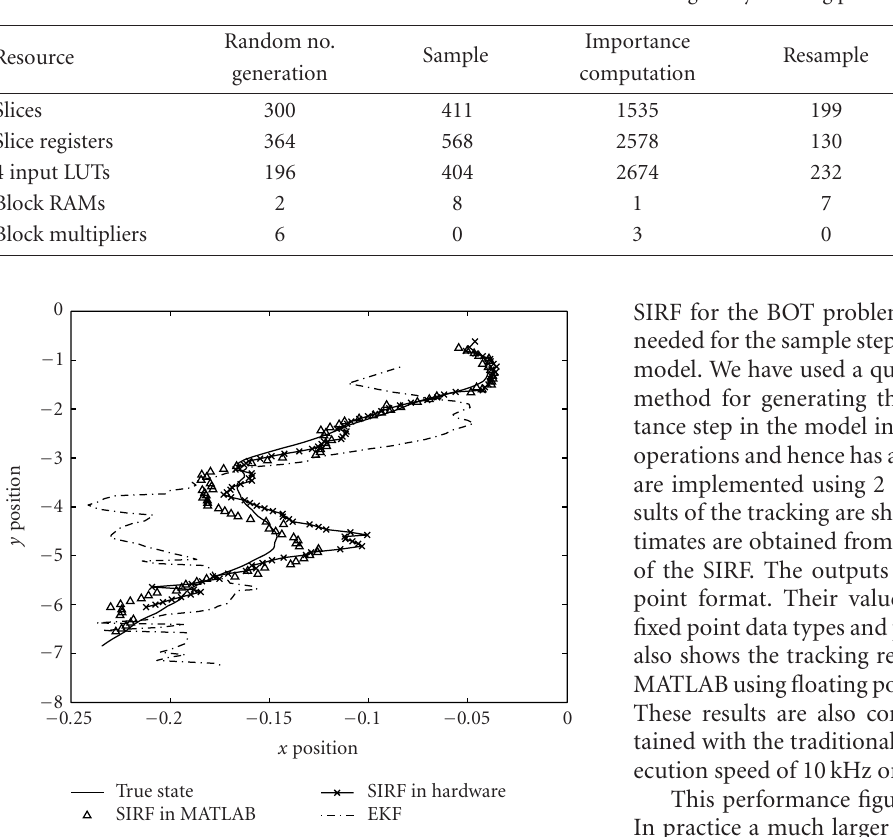
Figure 13: Results of tracking for the BOT